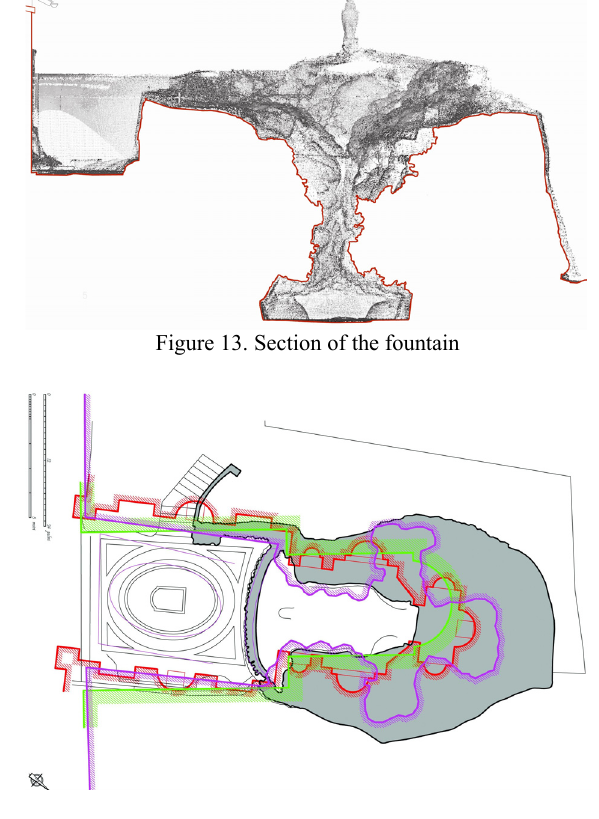
Figure 14. Hypothesis of overlap of the survey plan with the historical maps. (By Francesco